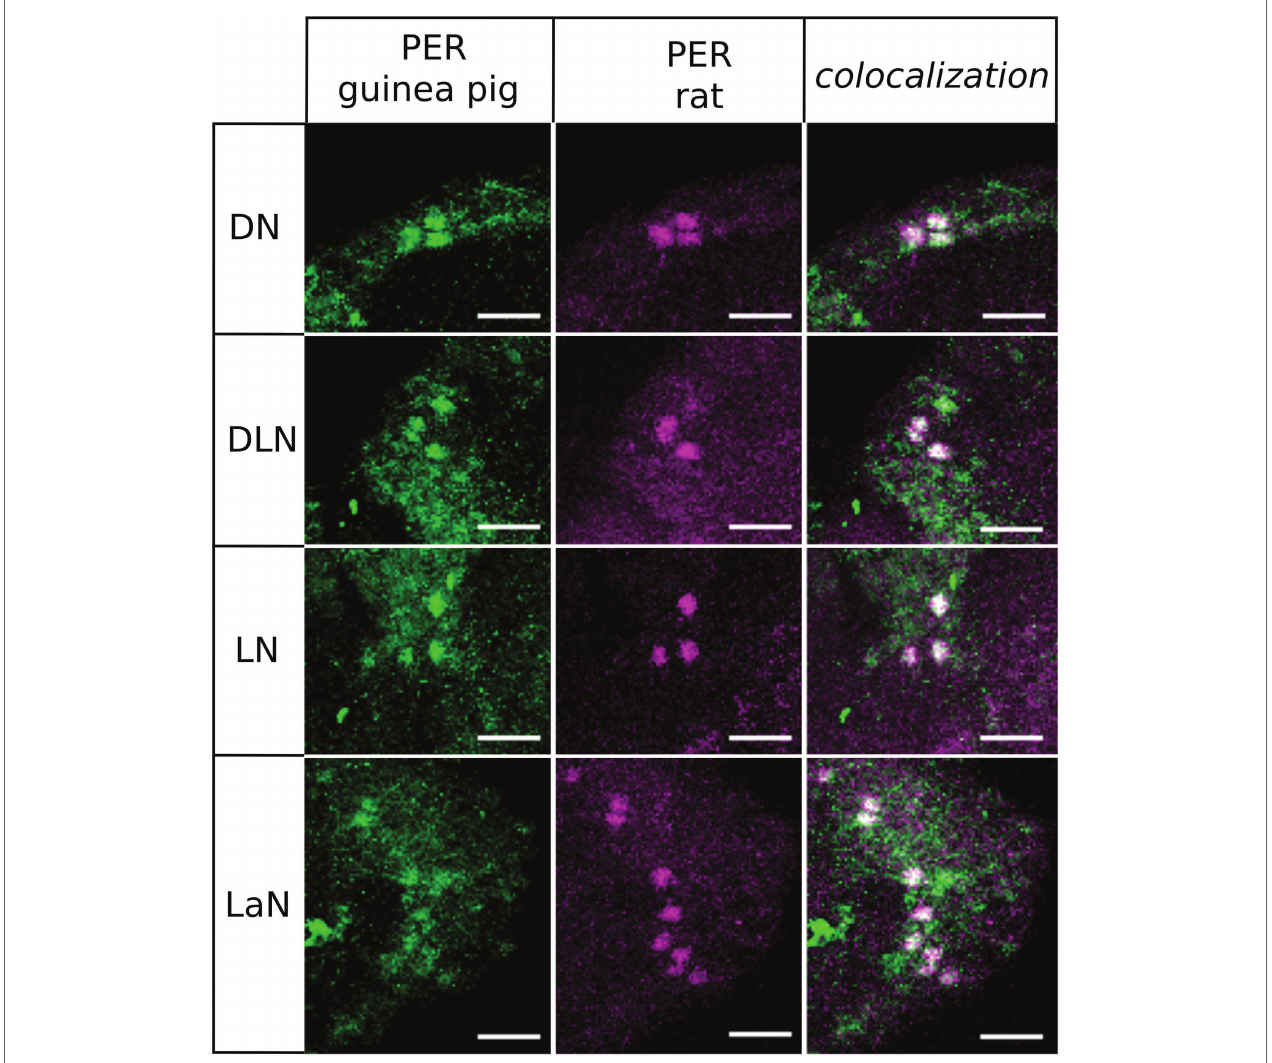
FIGURE 2 | Co-immunostainings with anti-PER raised in guinea pig and anti-PER raised in rat. We show that all clusters of clock neurons co-localize the two antibodies (overlay of five to eight confocal stacks, scale bar: 15 μ